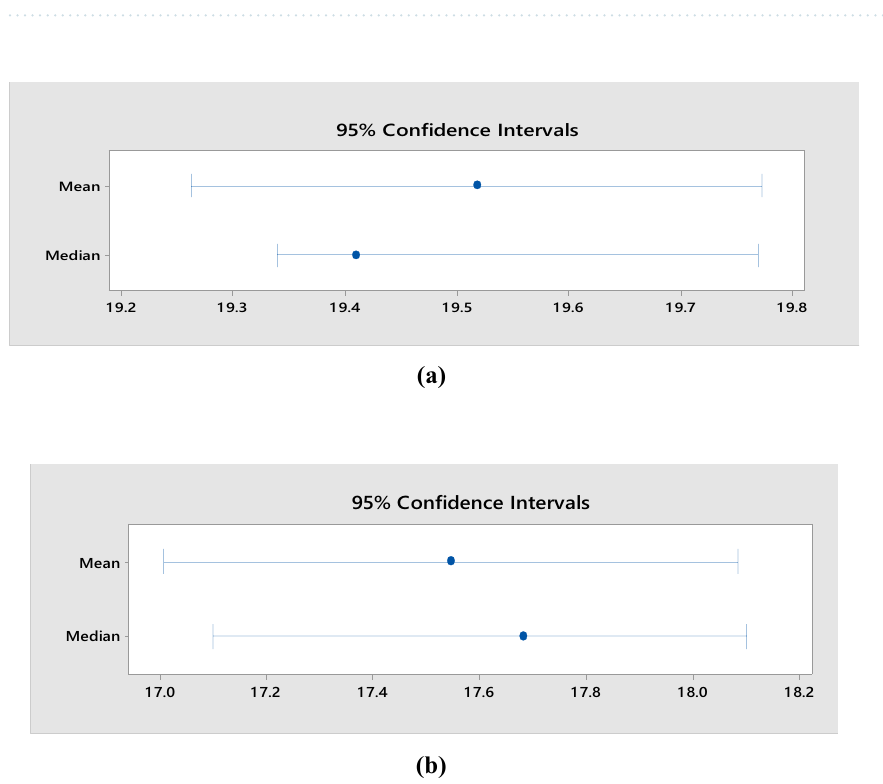
Table 1. Material properties used for modeling 57 .